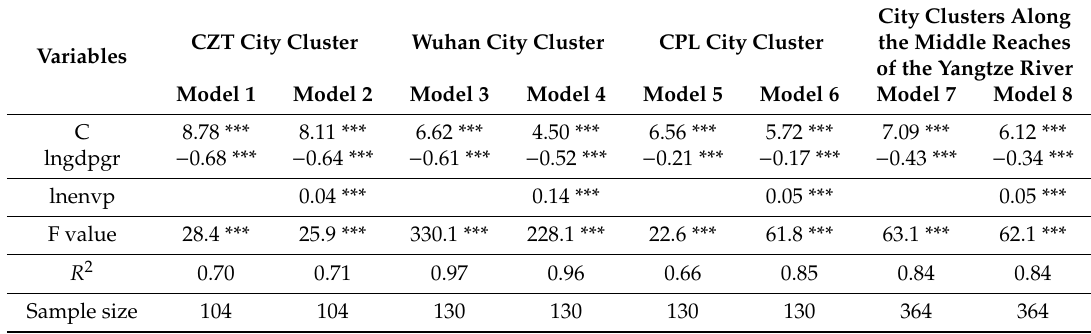
Table 3. Regression results on key explanatory variables. C: constant; R 2 : coe ffi cient of determination.